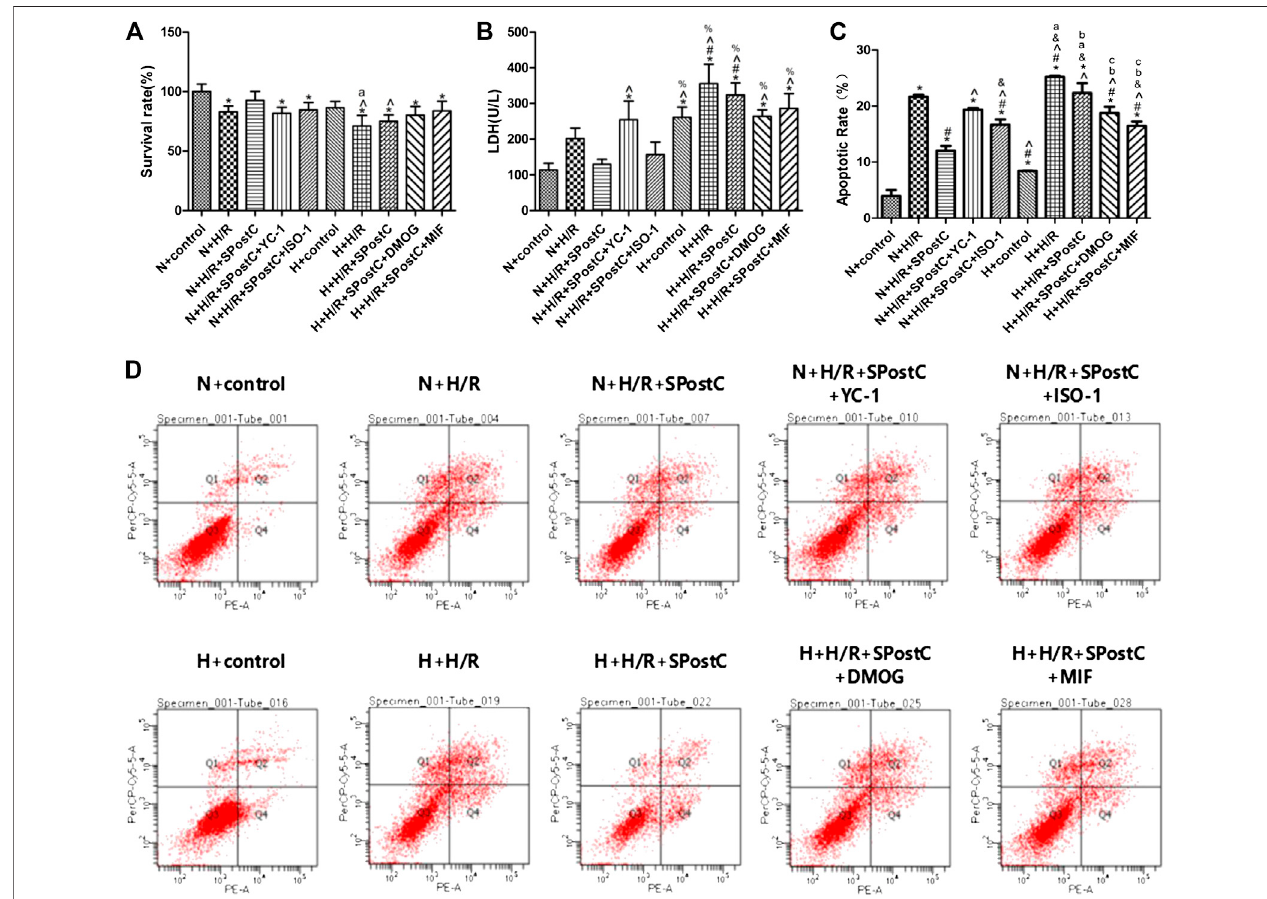
FIGURE2 | High glucose concentration wascell-damaging and abolished SPostC-induced cardioprotection. (A) Cell viability: Compared with N+ H/R group, N + H/R+SPostCgroupimprovedcellviability,butH+H/R+SPostCgroupfailedtoincreasecellviability(n (cid:2) 5/group). (B) LDHactivity:ComparedtoN+H/Rgroup,N+H/ R + SPostC group signi fi cantly reduced LDH content, but H + H/R + SPostC group failed to reduce LDH content (n (cid:2) 3/group). (C,D) Flow cytometry to measure apoptosis:Compared withN+H/Rgroup,N+H/R+SPostCgroupreducedcellapoptosis, butH+H/R +SPostCgroupfailedtoeffectivelyreducecellapoptosis (n (cid:2) 3/group).Datarepresentmean ± SD,vs.N+CONgroup* p < 0.05;vs.N+H/Rgroup # p < 0.05;vs.N+H/R+SPostCgroup ^ p < 0.05;vs.N+H/R+SPostC+YC-1 group & p < 0.05; vs. N + H/R + SPostC + ISO-1 group % p < 0.05; vs. H + CON group a P < 0.05; vs. H + H/R group b P < 0.05; vs. H + H/R + SPostC group c P <